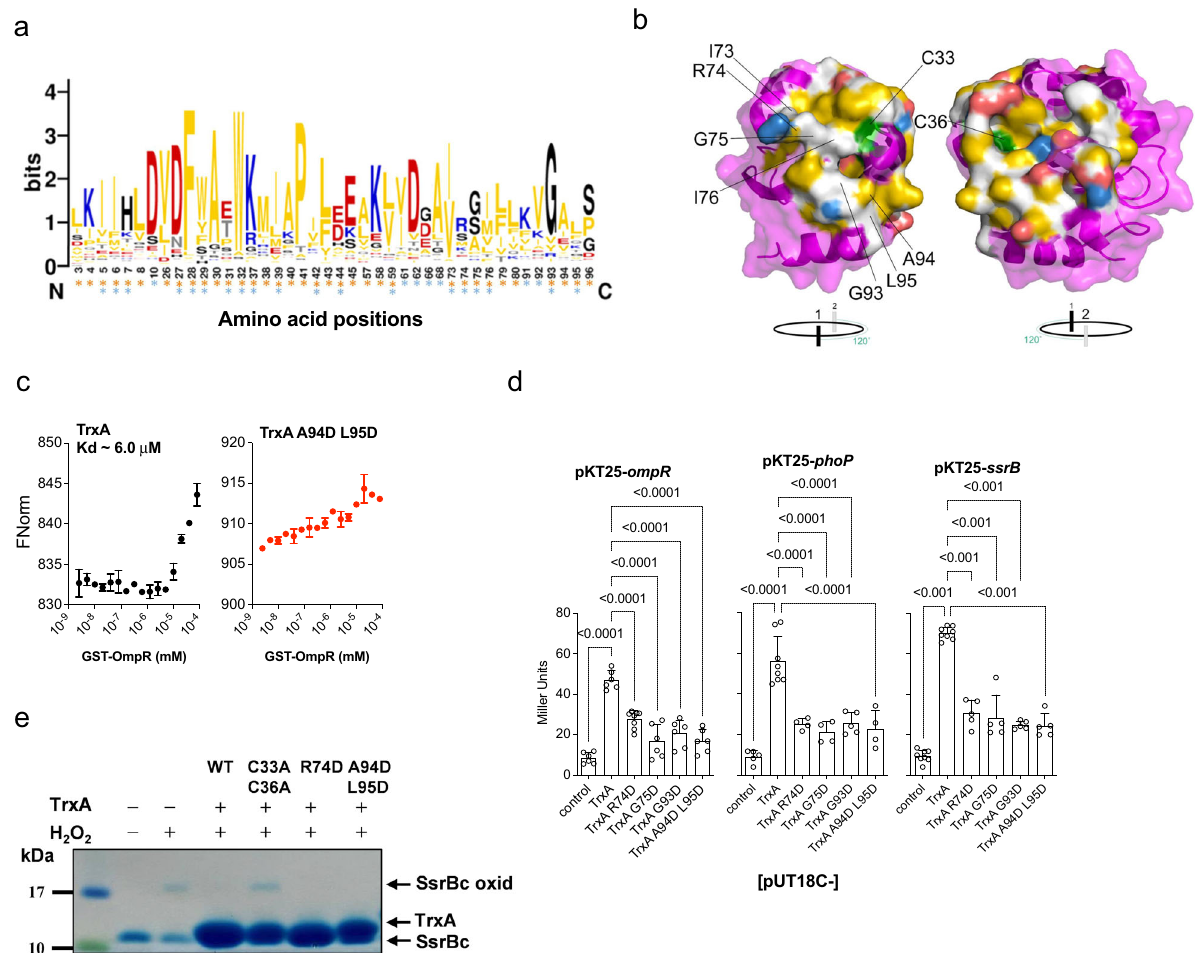
Fig. 3 | The TrxA interface serves as docking station to response regulators. a A consensus logo generated from results of a 3D-BLAST search on TrxA (PDB 4HUA) after alignment by ClustalW, n =448, e-value<1 − 10 . Asterisks represent thioredoxin-binding residues that interact with OmpR (orange) or PhoP (blue). b The~4400Å 2 TrxAbindinginterfacethatmediatesassociationstoOmpRorPhoP ishighlightedblue,red,yellow,orgraytoshowpositive,negative,hydrophobic,or hydrophilic identities, while the catalytic cysteine residues are in green. Residues probed by mutagenesis are labeled. c Binding af fi nity of the wildtype TrxA or the TrxA A94D L95D variant to GST-OmpR was estimated by microscale thermophor- esis. The calculated Kd value is displayed. The data are mean±SD from 2 inde- pendentexperiments. d InteractionofTrxAvariantswithOmpR, PhoP,and SsrBas assessed in a bacterial two-hybrid system. E. coli strains expressing pUT18C empty vector with pKT25- ompR , - phoP , or - ssrB were used as a negative control. β -